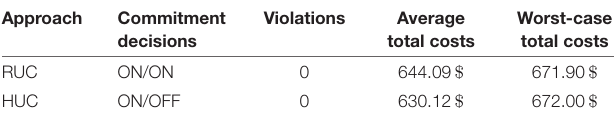
TABLE 1 | Comparison between RUC and HUC.